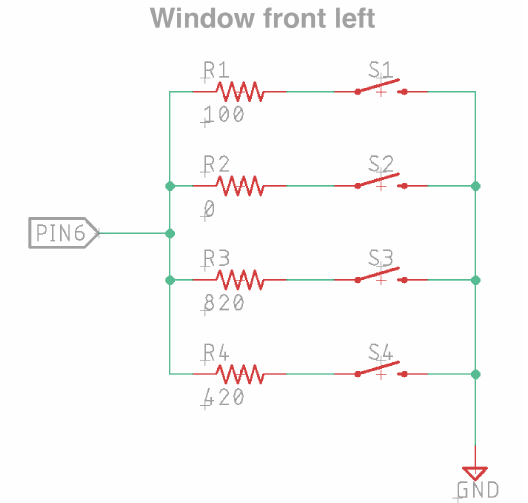
Figure 14. The signals measured by applying all of the functions to the window pane: Descend, Full Descend, Ascend, and Full Ascend. (Left to right, top to bottom)